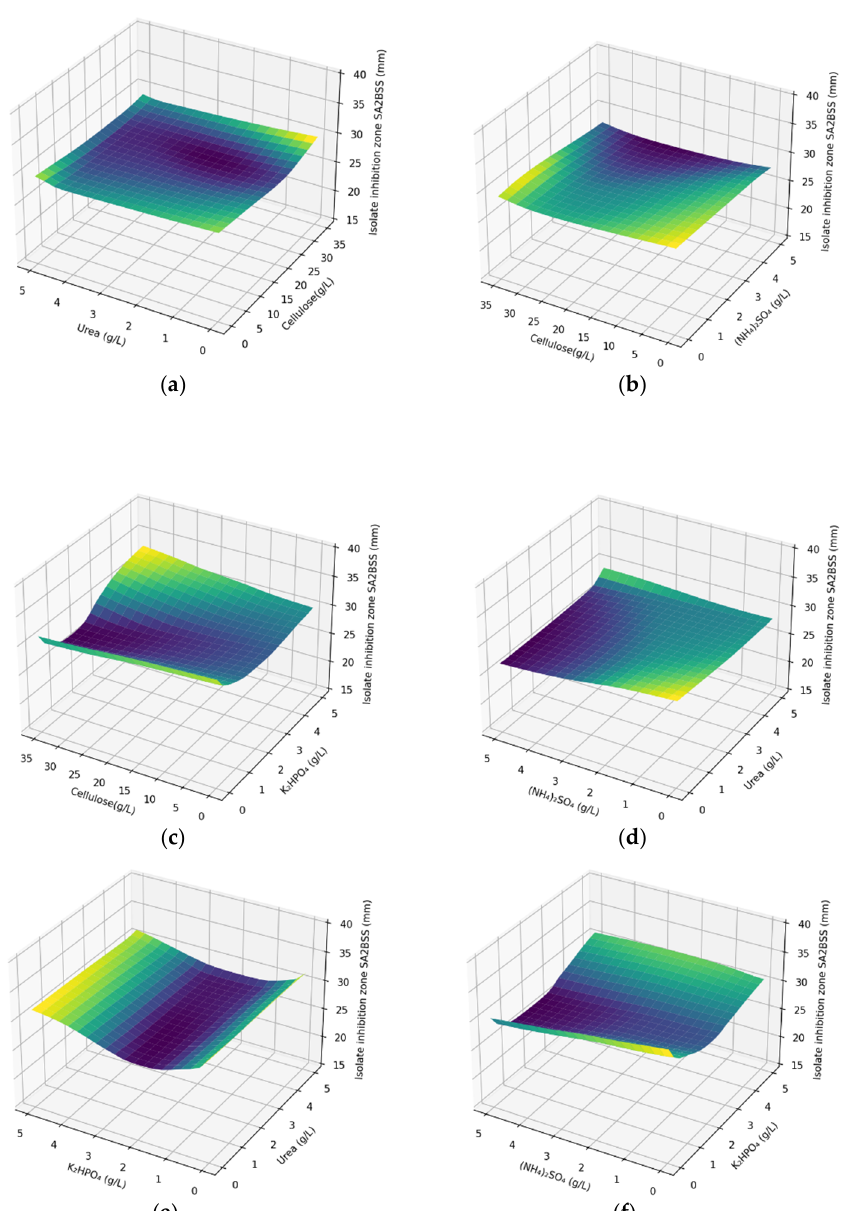
Figure A3. Response surface plots for effects of nutrients’ content on inhibition-zone diameter for Aspergillus flavus SA2BSS (ANN methodology): ( a ) cellulose and urea, ( b ) cellulose and (NH 4 ) 2 SO 4 , ( c ) cellulose and K 2 HPO 4 , ( d ) urea and (NH 4 ) 2 SO 4 , ( e ) K 2 HPO 4 and urea, ( f ) K 2 HPO 4 , and (NH 4 ) 2 SO 4 .